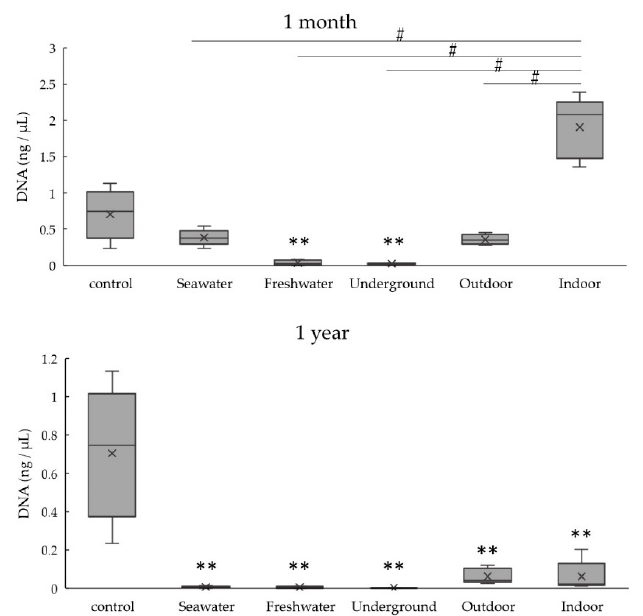
Figure 3. Differences in the amount of DNA between the five environmental conditions at 1 month and 1 year. Data are presented as means and standard deviations. ** p < 0.01 vs. control, # p < 0.01.